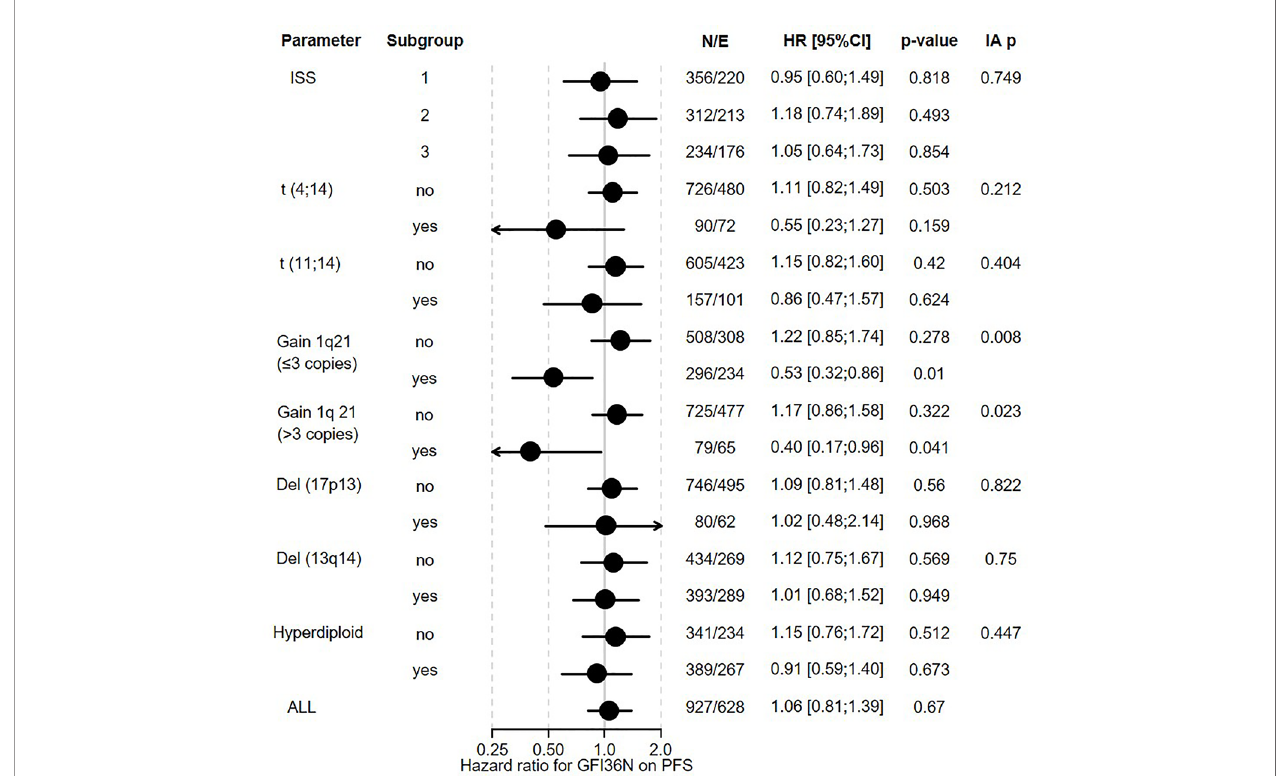
FIGURE 3 | In fl uence of GFI1-36N on PFS of different subgroups of MM patients. GFI1-36N (homo or heterozygous) MM patients were strati fi ed according to presence/absence/levels of different parameters, International Staging System (ISS), t(4;14), t(11;14), gain 1q21 ( ≤ 3 copies), or gain 1q21 (>3 copies), Del (17p13), Del (13q14), hyperdiploid and statistically evaluated for PFS. Hazard ratio including 95% con fi dence interval based on Cox regression is presented. IA p: test on the interaction between subgroups, N/E: Number of patients and events within the subgroup.